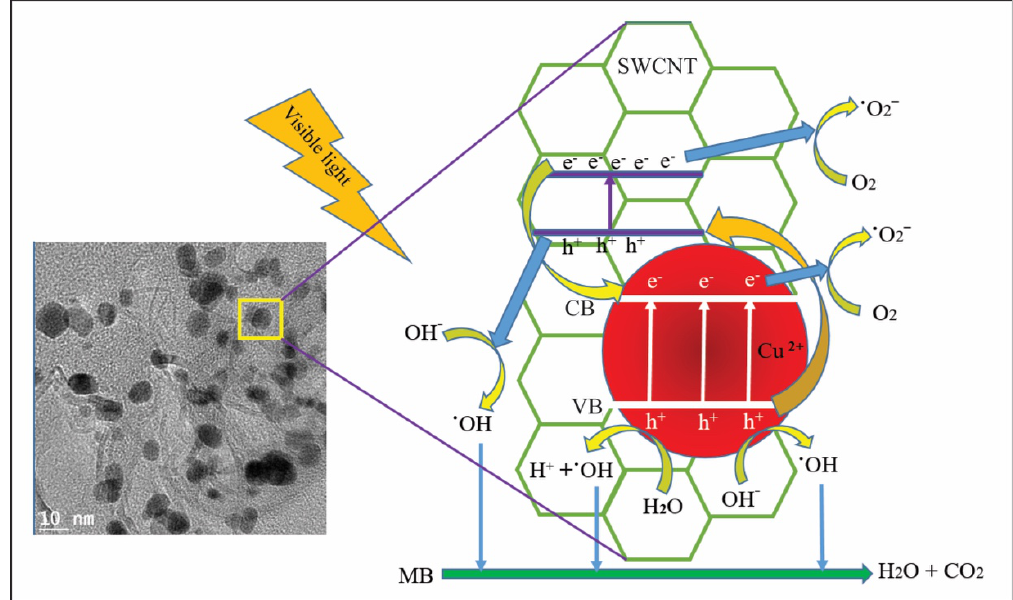
Figure 8. Proposed mechanism of generation of active species and deterioration of MB in the presence of sunlight (valence band (VB) and conduction band (CB) levels as well as particle sizes are not drawn to